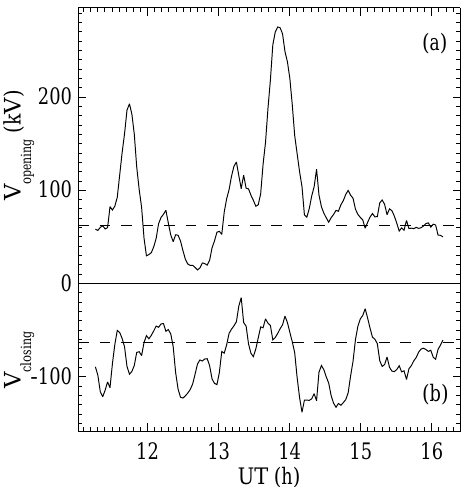
Figure 13. Dayside (a) and nightside (b) reconnection voltages de- termined by Hubert et al. (2008) during the sawtooth event that occurred on 24 October 2002. The horizontal dashed lines show how the 66% thresholding separates large from smaller reconnec- tion rates.